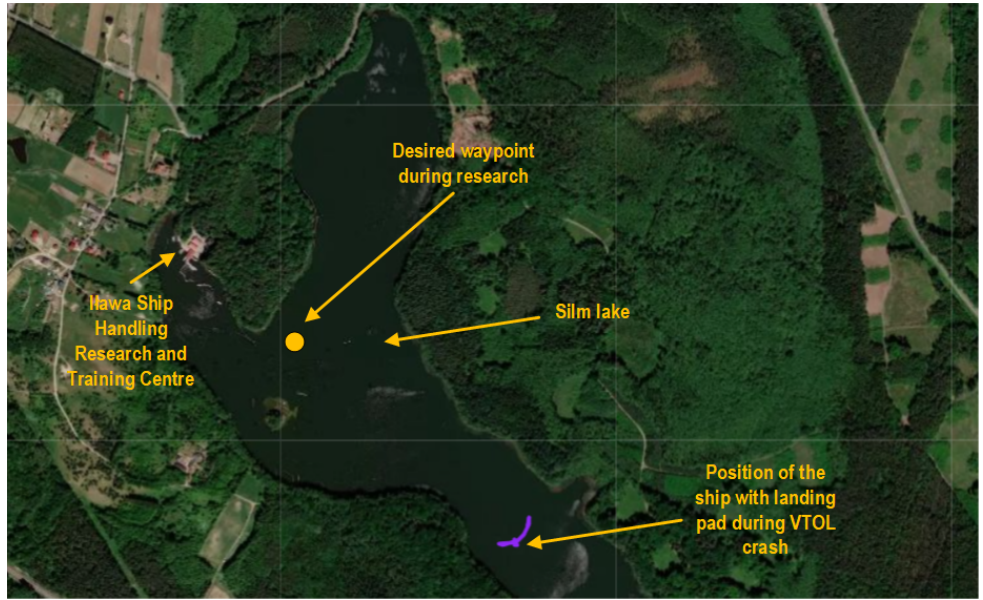
Figure 4. VTOL UAV research area during quasi-real